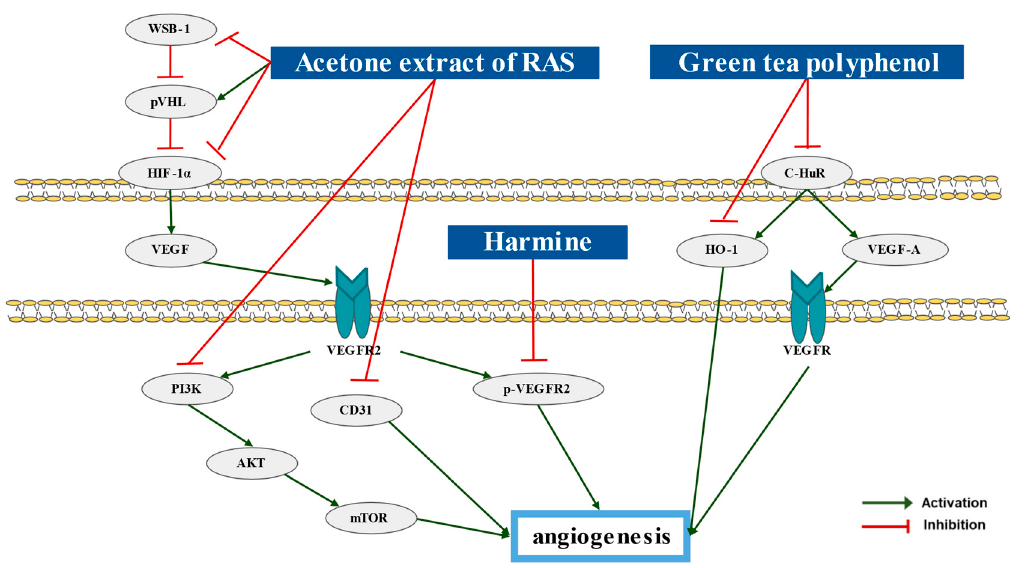
Figure 6. Natural products and angiogenesis. HIF-1a promotes VEGF expression to activate VEGFR2. Due to activated VEGFR2, PI3K, AKT, and mTOR expression levels are sequentially increased, resulting in angogenesis. Activated VEGFR2 also promotes p-VEGFR2 expression and causes angogenesis. AE-AS inhibits all substances in this process. It also increases pVHL expression inhibiting HIF-1a, the beginning of the process, and re-inhibits WSB-1 inhibiting pVHL, and harmine inhibits p-VEGFR2 resulting in angiogenesis. Moreover, C-HuR causes angiogenesis. GTP intake suppresses the expression of HO-1 directly and that of HO-1 and VEGF-A indirectly via regulation of C-HuR expression. Abbreviation: AKT (PKB), protein kinase B; CD31, cluster of differentiation 31; C-HuR, Cytoplasmic human antigen R; HIF-1 α , hypoxia-inducible factor-1 α ; HO-1, hemeoxygenase-1; mTOR, mammalian target of rapamycin; PI3K, phosphatidylinositide-3 kinases; p-VEGFR2, protein-VEGFR2; pVHL, p-von Hippel-Lindau tumor suppressor; RAS, root of Angelica sinensis; VEGF, vascular endothelial growth factor; VEGFR2, VEGF-receptor-2; WSB-1, WD repeat